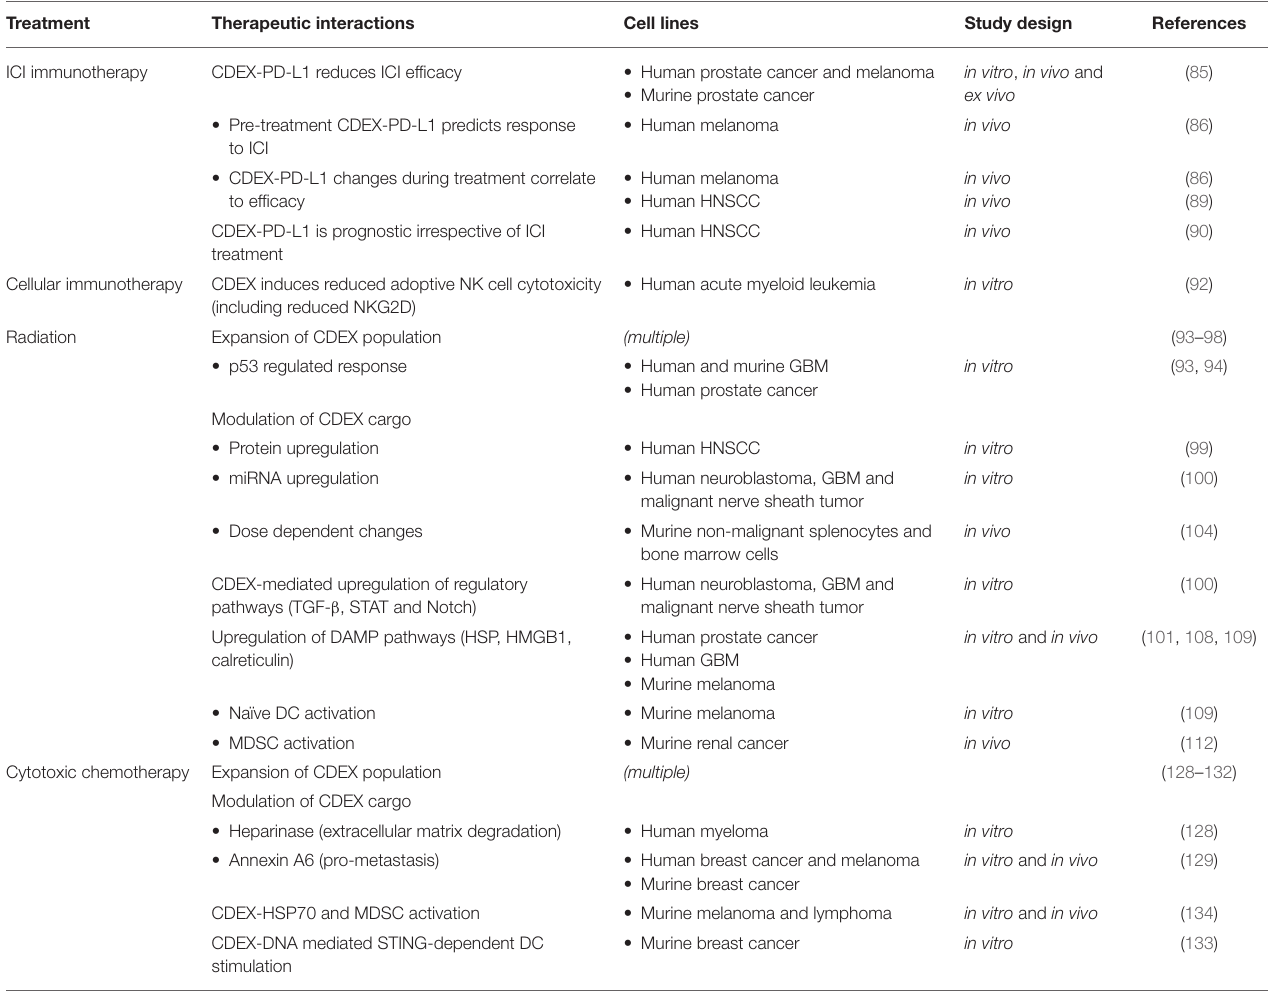
TABLE 1 | Summary of cancer-derived exosome mediated immune interactions with oncological therapies.